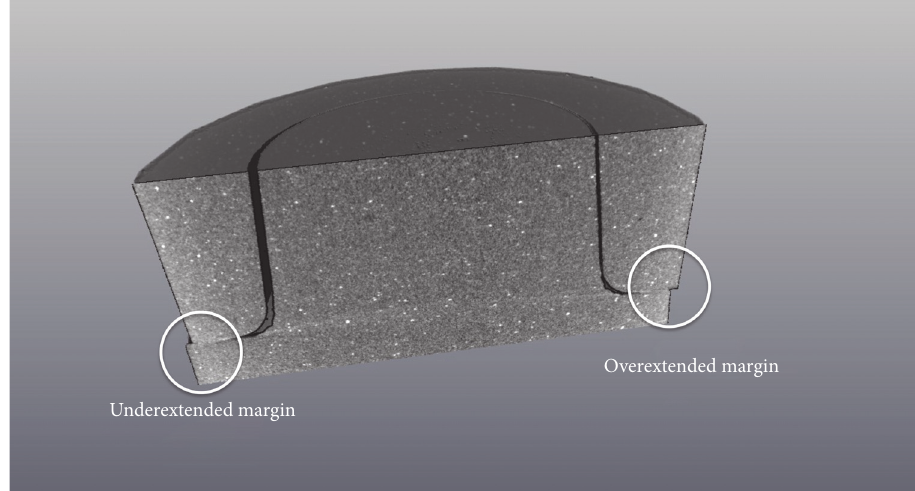
Figure 10: Direct 3D visualization of margin over- and underextension, due to misalignment of the prepared tooth and prosthesis